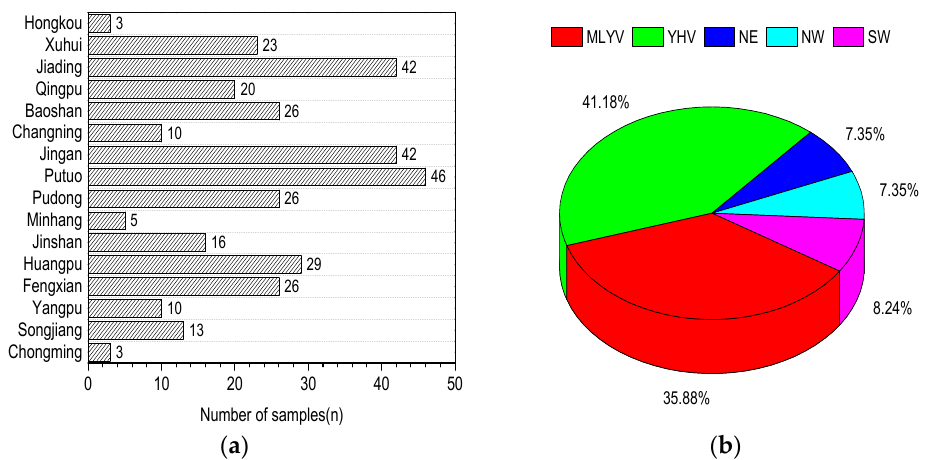
( a ) ( b ) Figure 2. ( a ) The number of wheat-based products samples and the sample collection location in Shanghai city; ( b ) the proportion of the geographic origin of the samples.